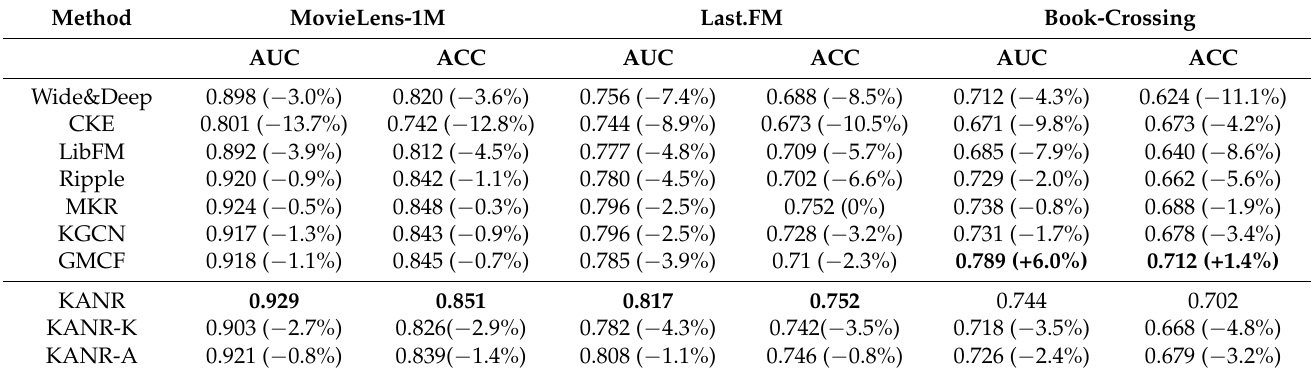
Table 2. The performance of each model in CTR prediction. The best results are in